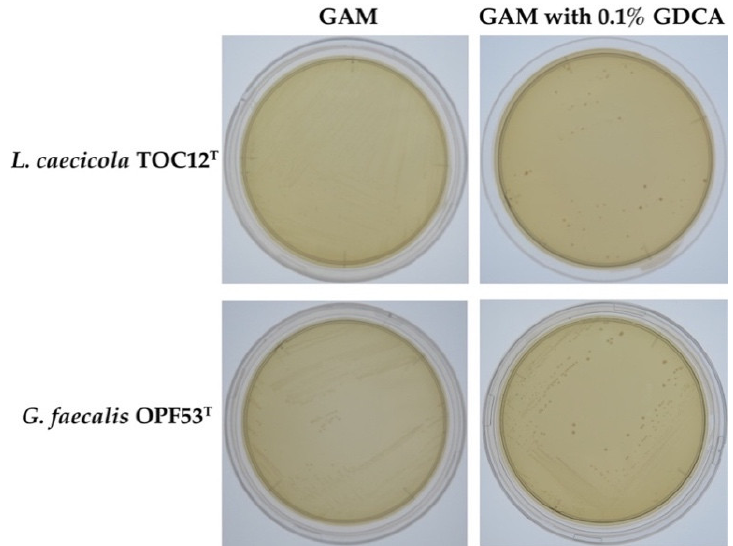
Figure 1. Bile salt hydrolase (BSH) activity in Leptogranulimonas caecicola TOC12 T and Granulimonas faecalis OPF53 T . Full-grown cultures were streaked on a Gifu anaerobic medium (GAM) agar plate ( left ) and a GAM agar plate supplemented with 0.1% glycodeoxycholic acid ( right ). All plates were anaerobically incubated at 37 °C for 5 days. The visible precipitates surrounding colonies are the well-known indicators of bacterial BSH activity [12,27].